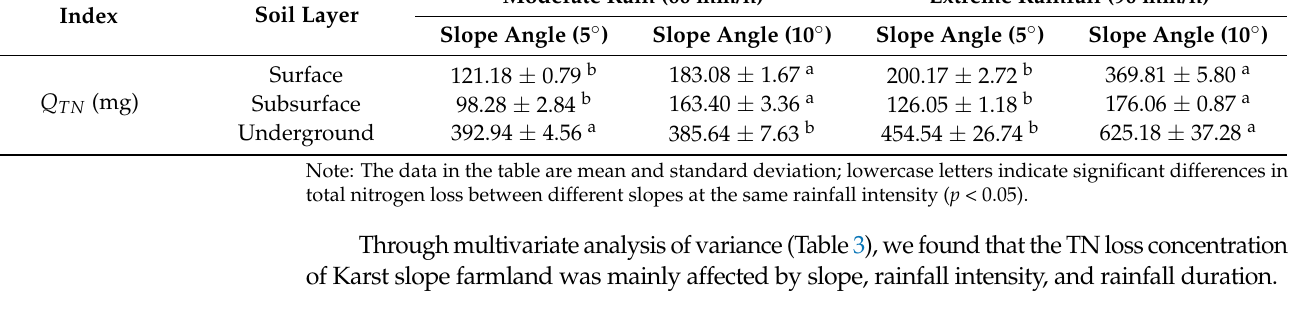
Table 3. Multivariate analysis of variance of TN concentration and influencing